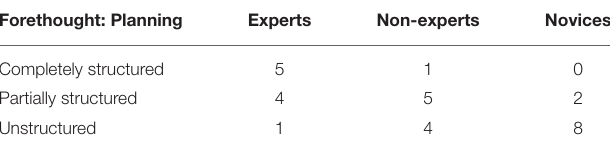
TABLE 4 | An overview of how different routines were used across the three skill levels.